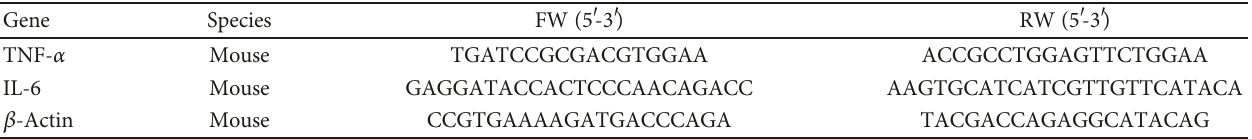
Table 1: Primers used for real-time qPCR